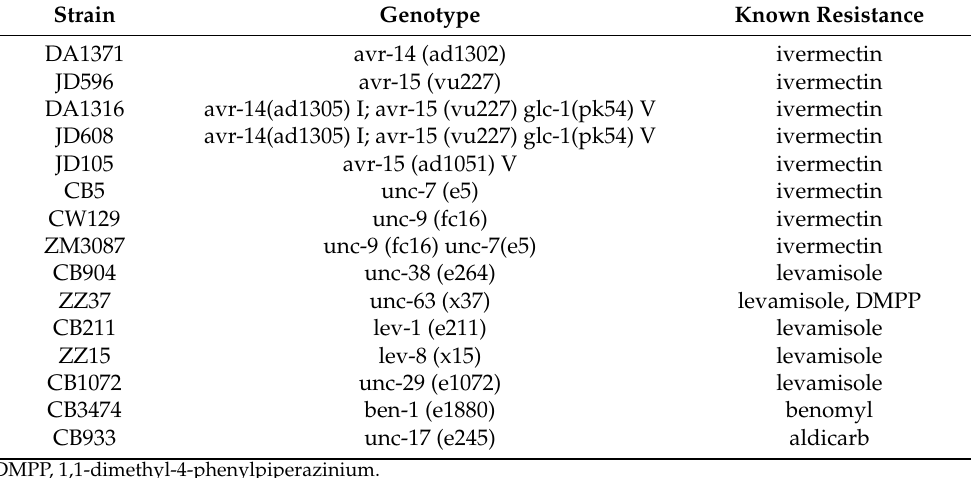
Table 2. Drug-resistant mutant strains of C. elegans used in this study.